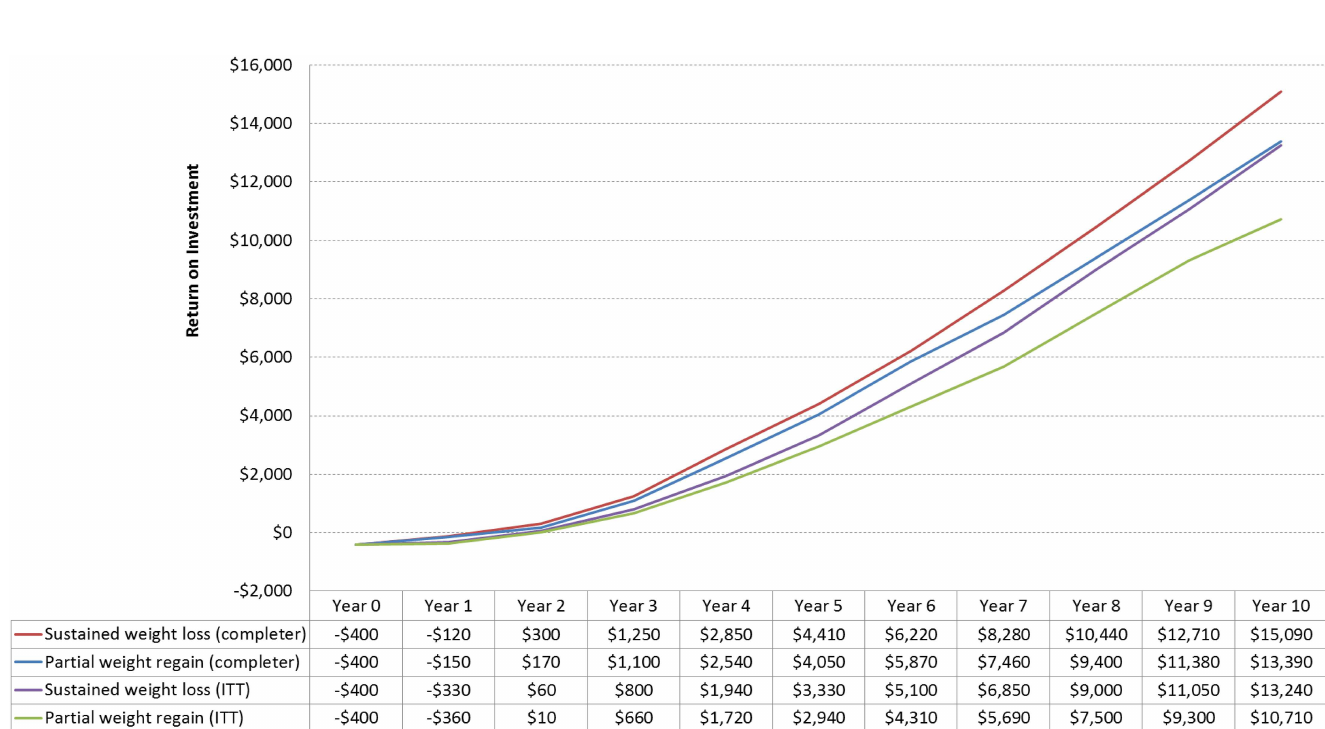
Fig 2. Projected Average Return On Investment of Population with Prediabetes On Digital Intensive Behavioral Counseling Program